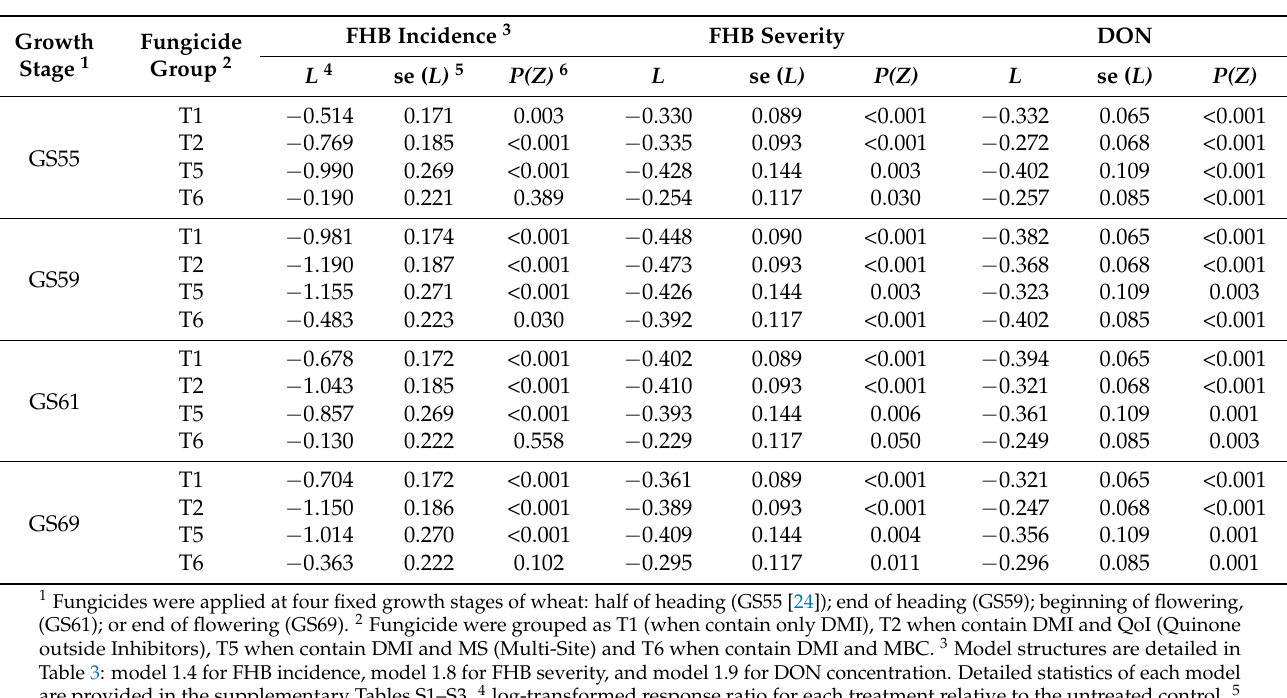
Table S3. 4 log-transformed response ratio for each treatment relative to the untreated control. 5 standard error of L. 6 Prob- ability value (significance level) of Z (standard normal statistic).